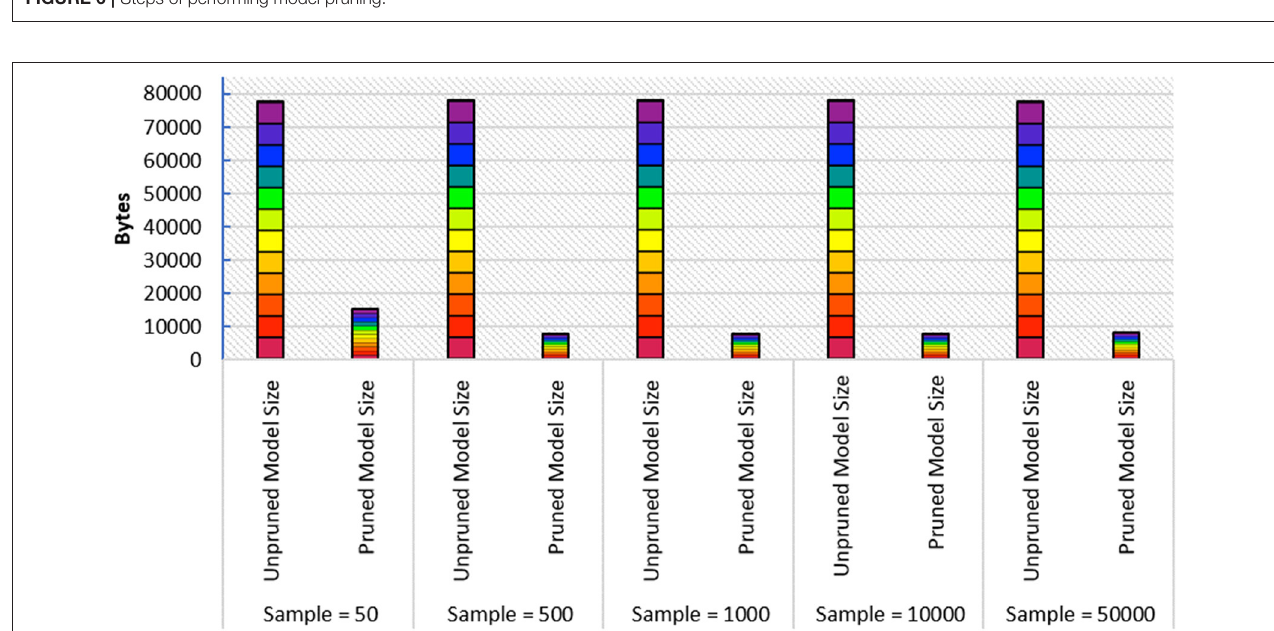
FIGURE 7 | Performing model pruning and achieving compressed model